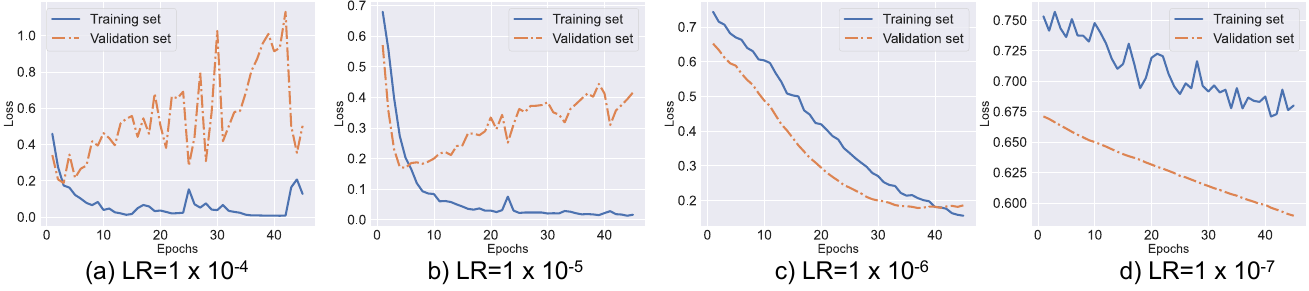
Figure 4. Learning rate effect on model